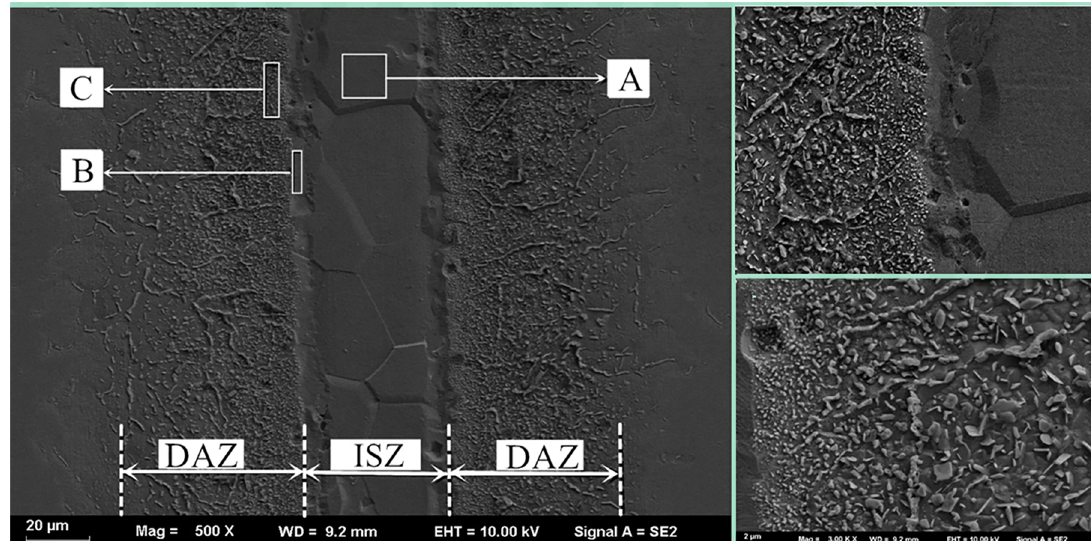
Figure 4. SEM microstructure of the brazed joint.